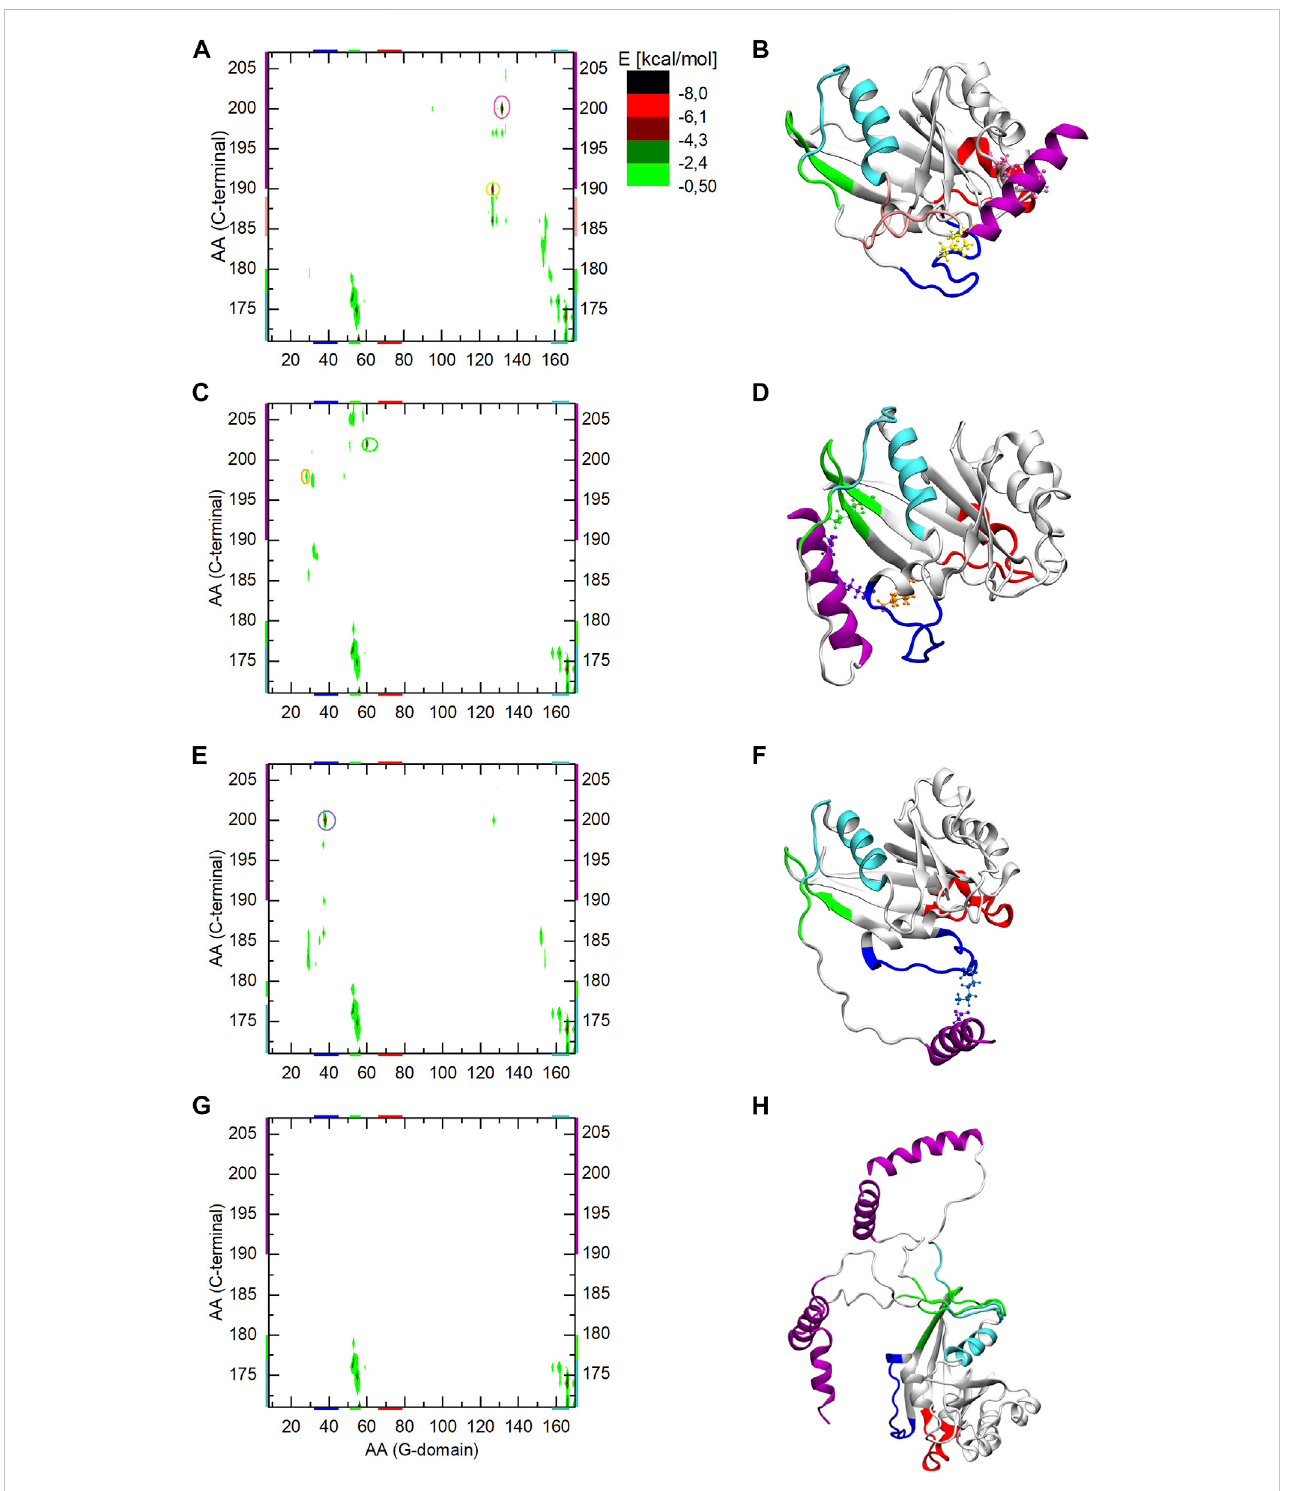
TheinteractionenergymapbetweentheG-domainandtheC-terminalofRan-GTPduringthethreeparallelMDsimulation(part A,C,E oftheFigure)and during aMDeNM simulation (part G of the Figure). The interacting regions are color-coded both along the axes or encircled on the graph, and mapped with identical coloring onto the corresponding end structures of the given simulation (part B,D,F, and H of the Figure). The reported energy values are statistical averages over given MD or aMDeNM